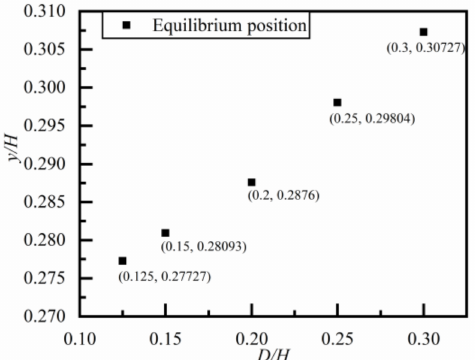
Figure 12. The equilibrium position of a single particle at different blocking ratios.